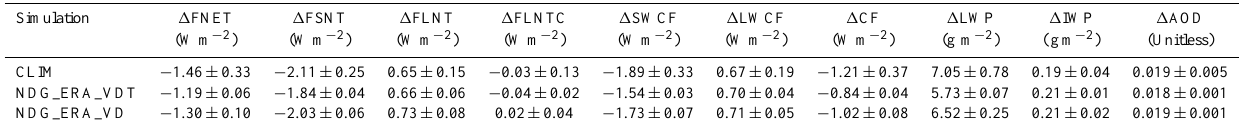
Table A4. As in Table A2 but for ECHAM6-HAM2. The simulation setups are explained in the caption of Table A3 and in Sect. 2.4. Simulation 1